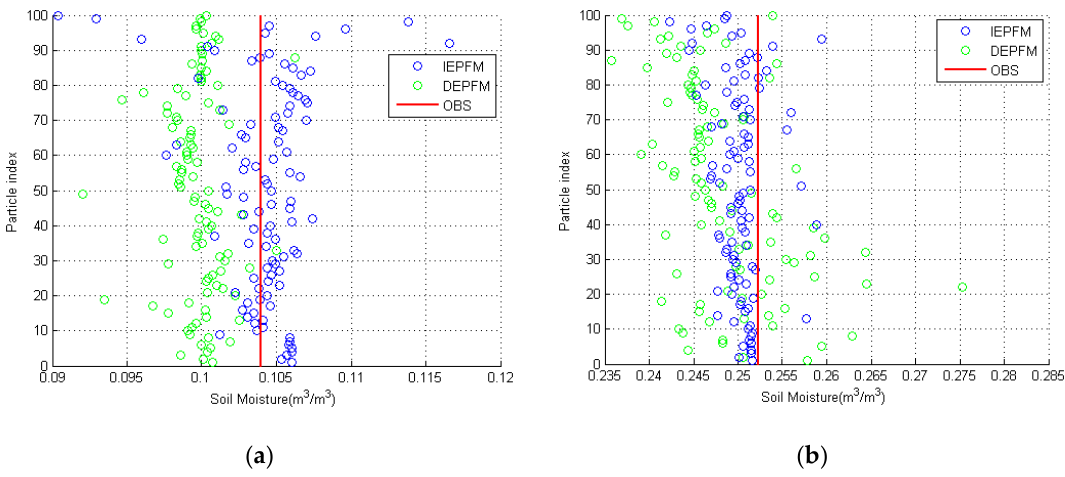
Figure 12. Scatter diagrams of the particles generated by IEPFM and DEPFM on different assimilation days. ( a ) t = 45, ( b ) t = 70. The blue and green circles present the particles generated by IEPFM and DEPFM, respectively. The corresponding SM of red line denotes the observation.